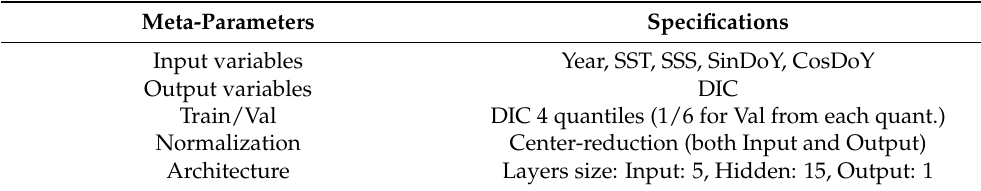
Table A1. Characteristics of the neutral networks